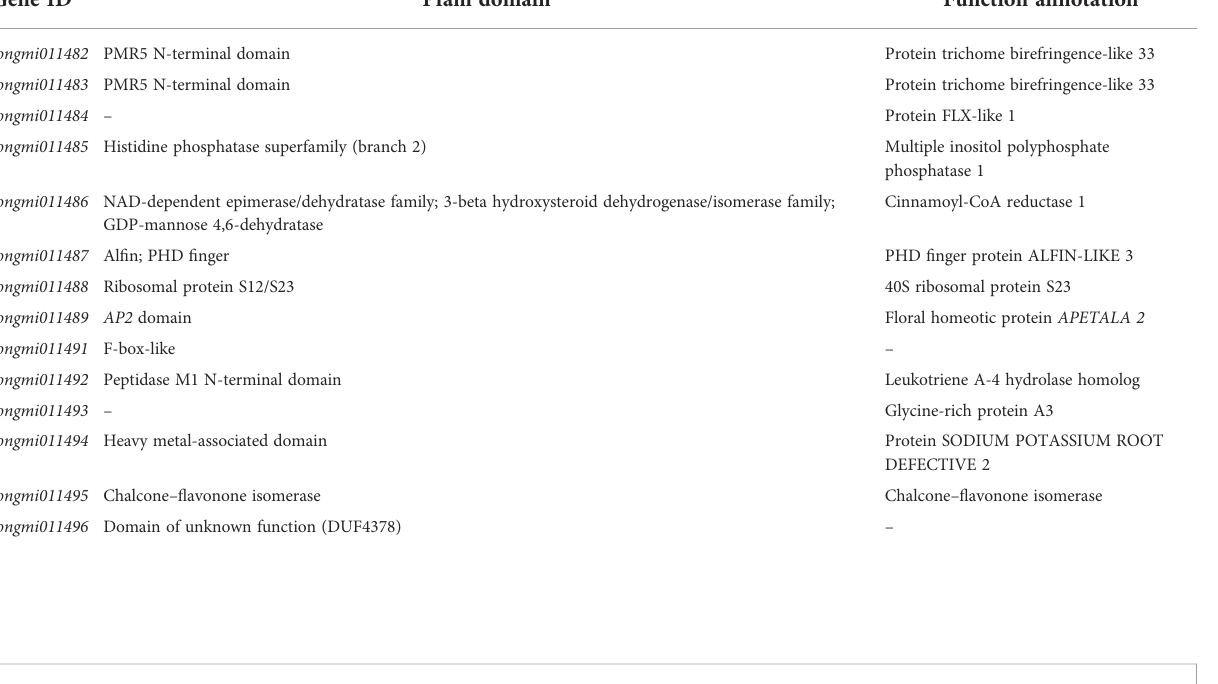
TABLE 2 Annotated function of the genes located in the interval of PH1.1 .